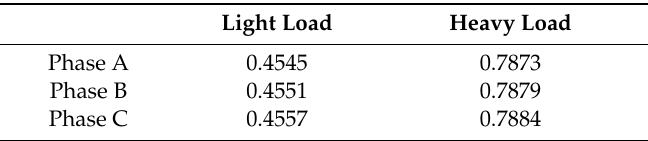
Table 4. Utilization factor in light and heavy load periods.